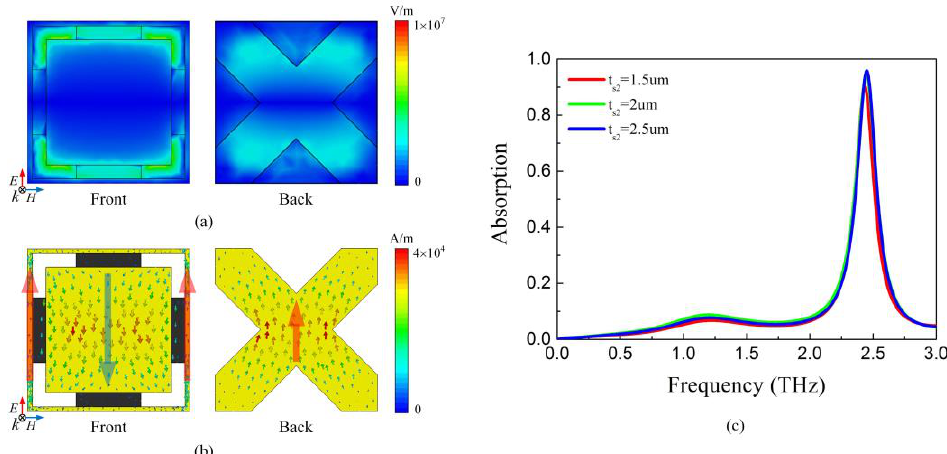
Figure 8. ( a ) The electric field distribution of the narrowband frequency-tunable absorber at 2.48 THz with E F = 0.3 eV ( b ) The current distribution of the narrowband frequency-tunable absorber at 2.48 THz with E F = 0.3 eV ( c ) Absorption spectrum of the narrowband frequency-tunable absorber with di ff erent t s2 when E F = 0.3